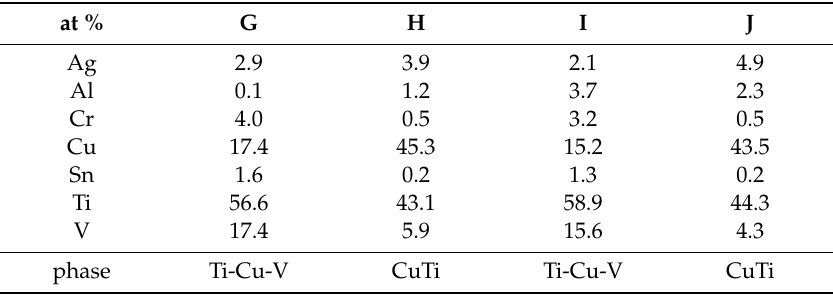
Figure 5. Cross-sectional observations of FESEM BEIs of Ti-15-3 substrate after wetting angle test using Ticusil ® filler metal at ( a ) 900 and ( b ) 950 °C for 300 s. Table 3. Chemical analyses in Figure 5 .